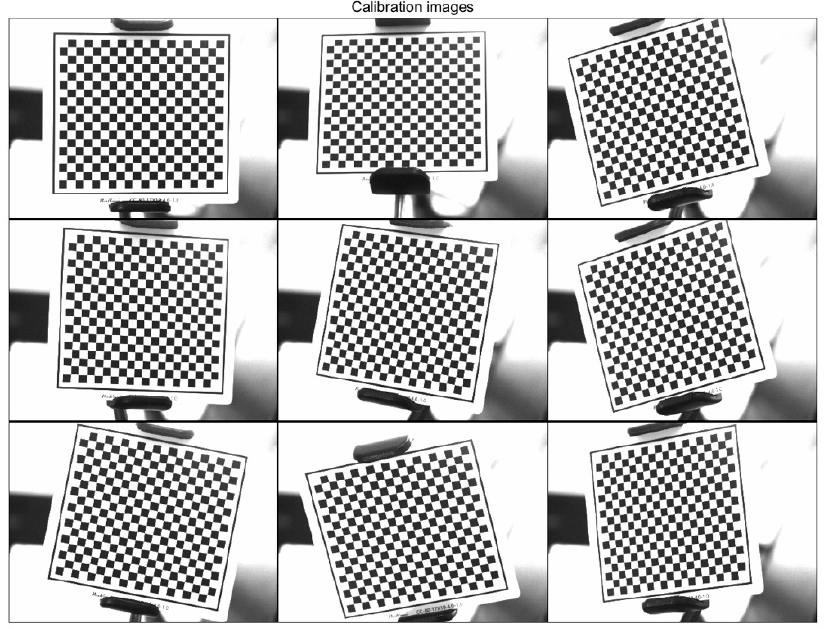
Figure 12. Camera Figure 12. Camera calibration.